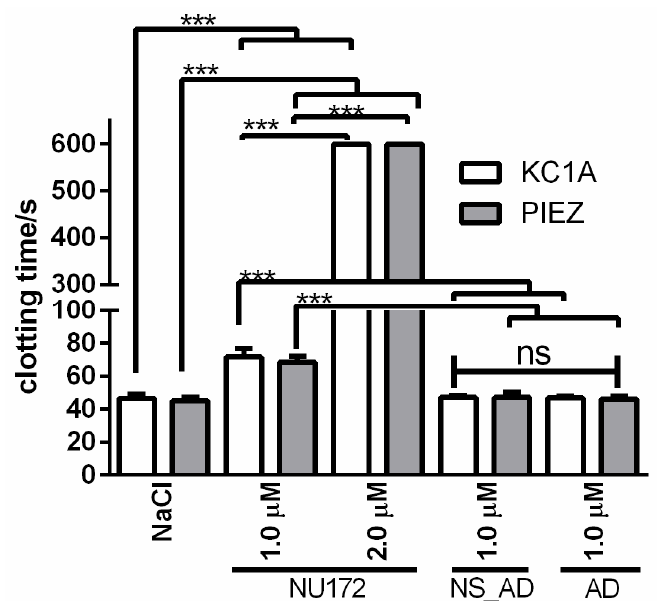
Figure 6. Detection of clotting time (CT) in heparinized blood using PIEZ or ball coagulometer (KC1A). Heparinized blood was incubated for 2 min with 1.0 or 2.0 µ M NU172. The coagulation was then activated with cephalin and factor X a , and the CT was measured. Furthermore, the CT was detected in blood without oligonucleotide addition (NaCl) or with 1.0 µ M NS_AD or AD. The statistical analysis was performed using two-way ANOVA (*** p < 0.001). (n = 10 ± SD).